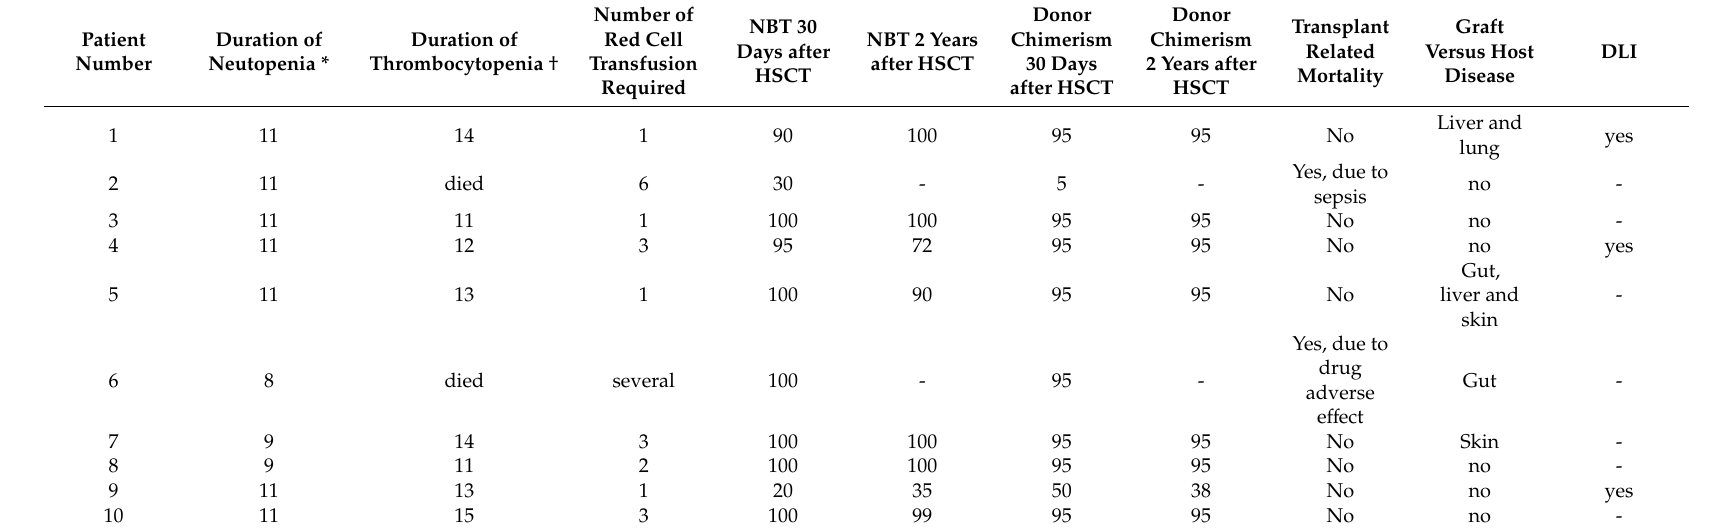
Table 2. Characteristics of HSCT course in the